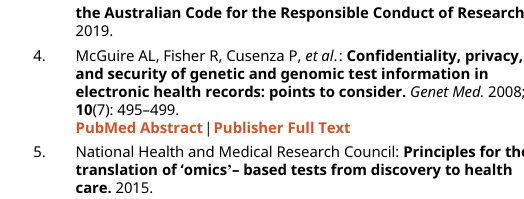
Figshare: Attitudes to Genetic Testing in Phase 1_Survey Data. https://doi.org/10.6084/m9.figshare.14204507.v1. 16